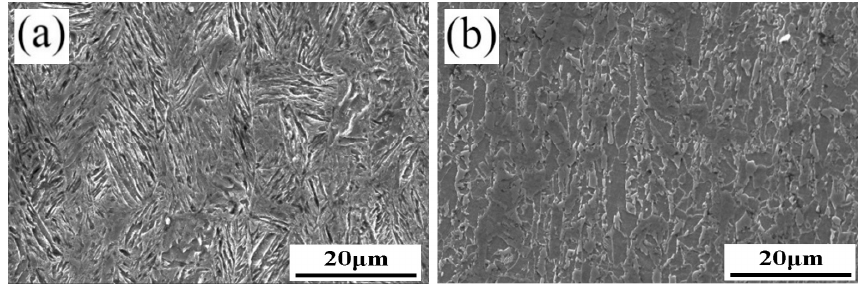
Figure 10. SEM micrographs of hot-rolled steels. ( a ) 22Mn3SiNb, ( b ) 22MnB5.